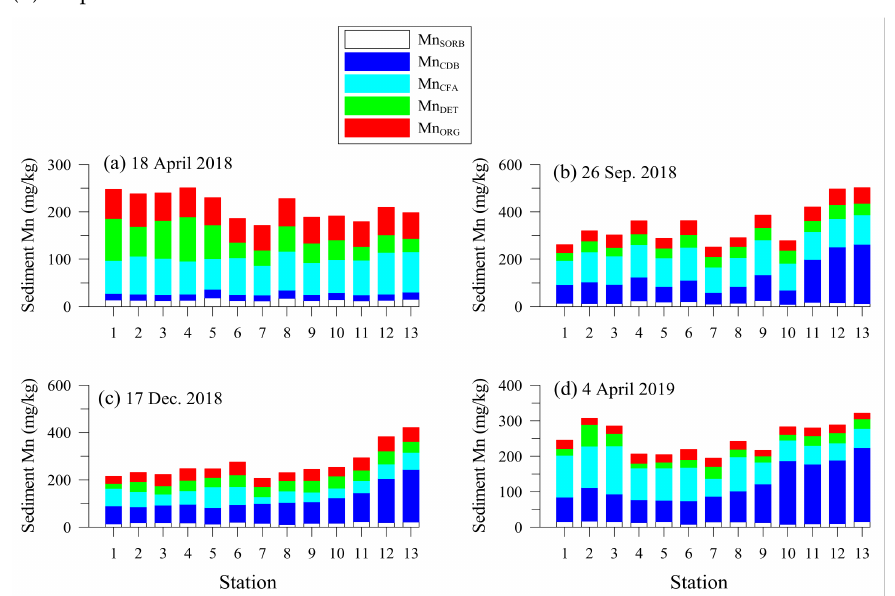
Figure 9. Seasonal distributions of the five Mn concentration fractions in the DRE surface sediments during the different surveys ( a ) 18 April 2018, ( b ) 26 September 2018, ( c ) 17 December 2018, and ( d ) 4 April